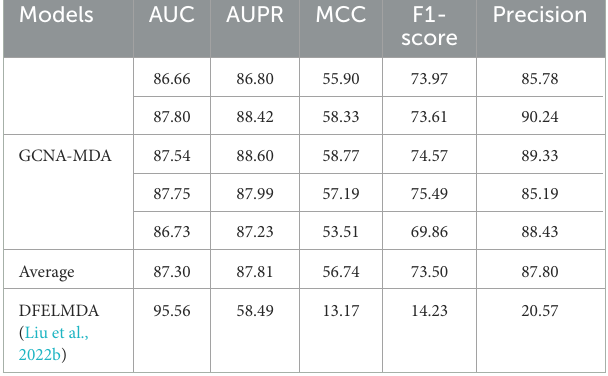
TABLE 2 Performance comparison of two models using autoencoders